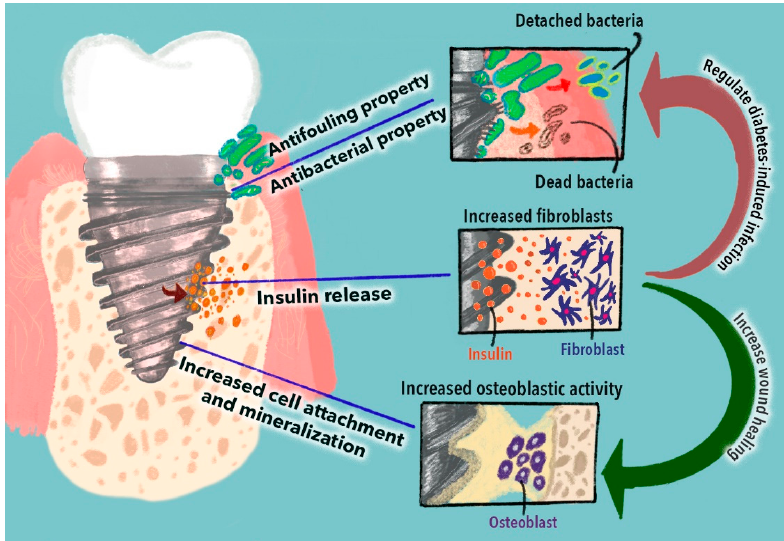
Figure 4. Strategies to modify biomimetic dental implants for diabetic patients.